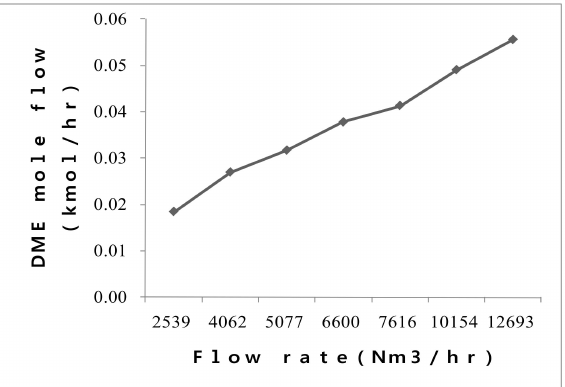
Figure 6. Influence of the flow rate on DME mole flow at the outlet of the